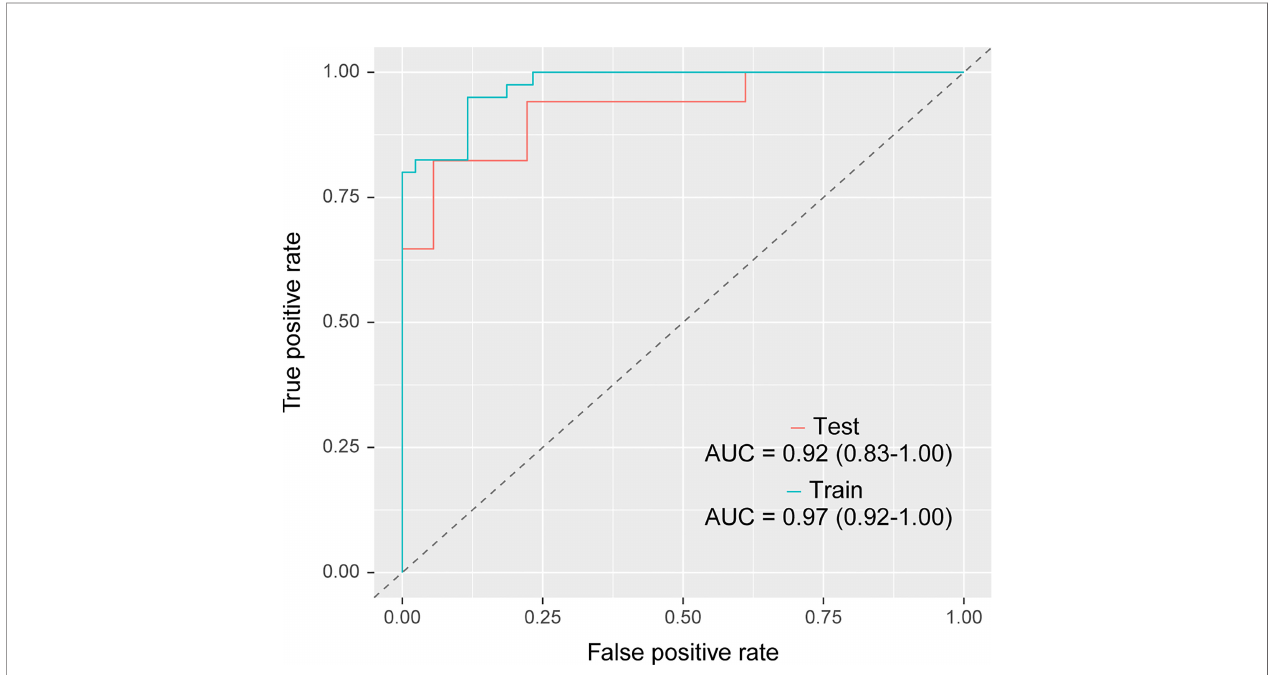
FIGURE 5 | Receiver operating characteristic curve analysis of the radiomics random forest prediction model in differentiating lung ground-glass nodule-type invasive adenocarcinoma and minimal invasive adenocarcinoma in the training group (blue line) and the veri fi cation group (red line). The areas under the curve of the training and veri fi cation groups were 0.97(95%CI, 0.92-1.00) and 0.92 (95%CI, 0.83 - 1.00), respectively. CI, con fi dence intervals.